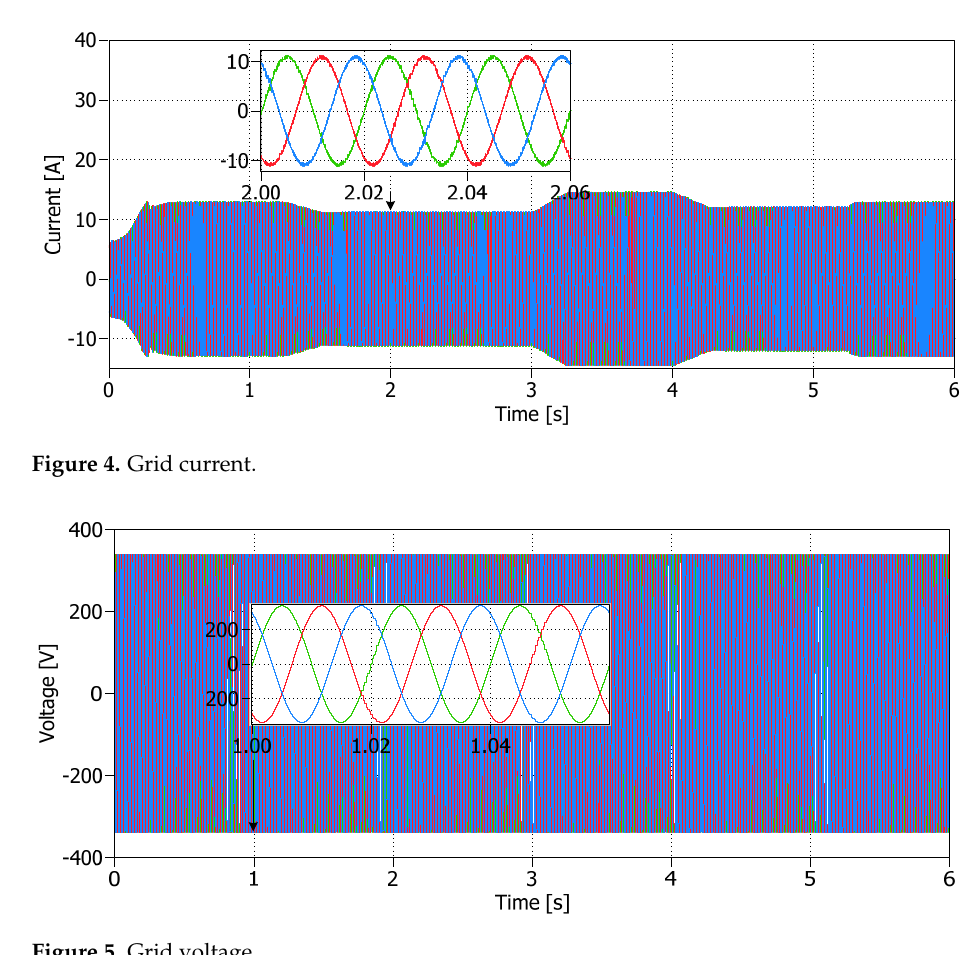
Figure 5. Grid voltage.